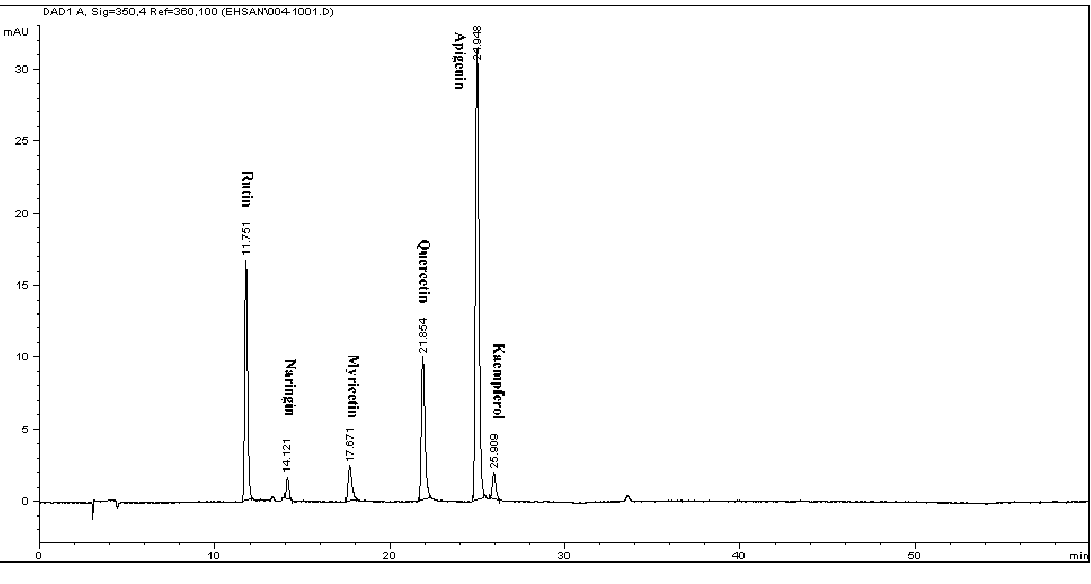
Figure 3. Chromatogram of flavonoids mixture of the standards detected at 350 nm by RP-HPLC: 11.76-rutin, 14.12-naringin, 17.67-myricetin, 21.854-quercetin, 24.85-apigenin and